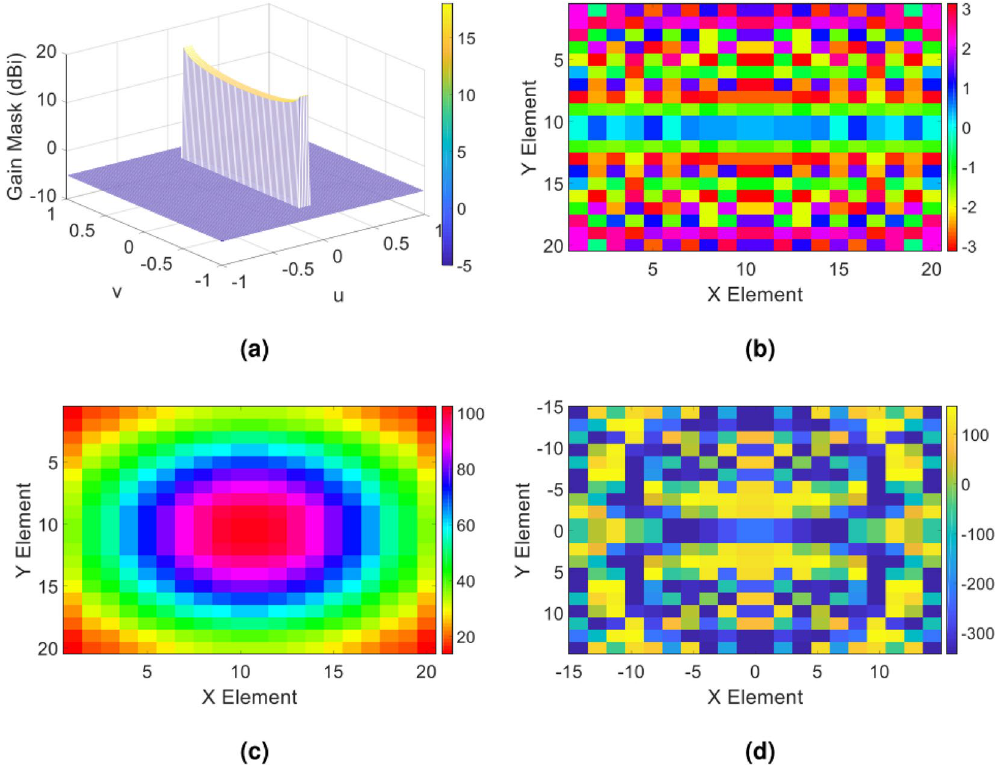
Figure 7. ( a ) The expected object wave in the (u, v) plane; ( b ) the phase and ( c ) amplitude of overall tangential electric field in the hologram plane; ( d ) the impedance distribution of the hologram obtained from the Eq.